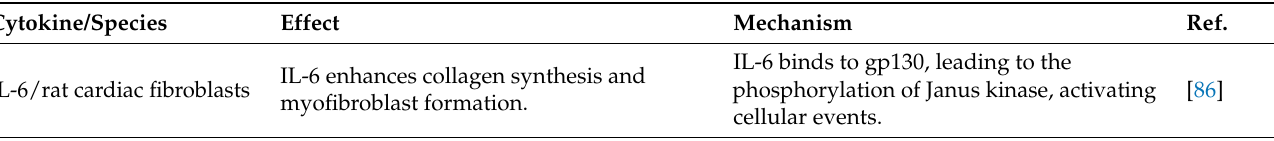
Table 1. Effects of pro-inflammatory cytokines on cardiac